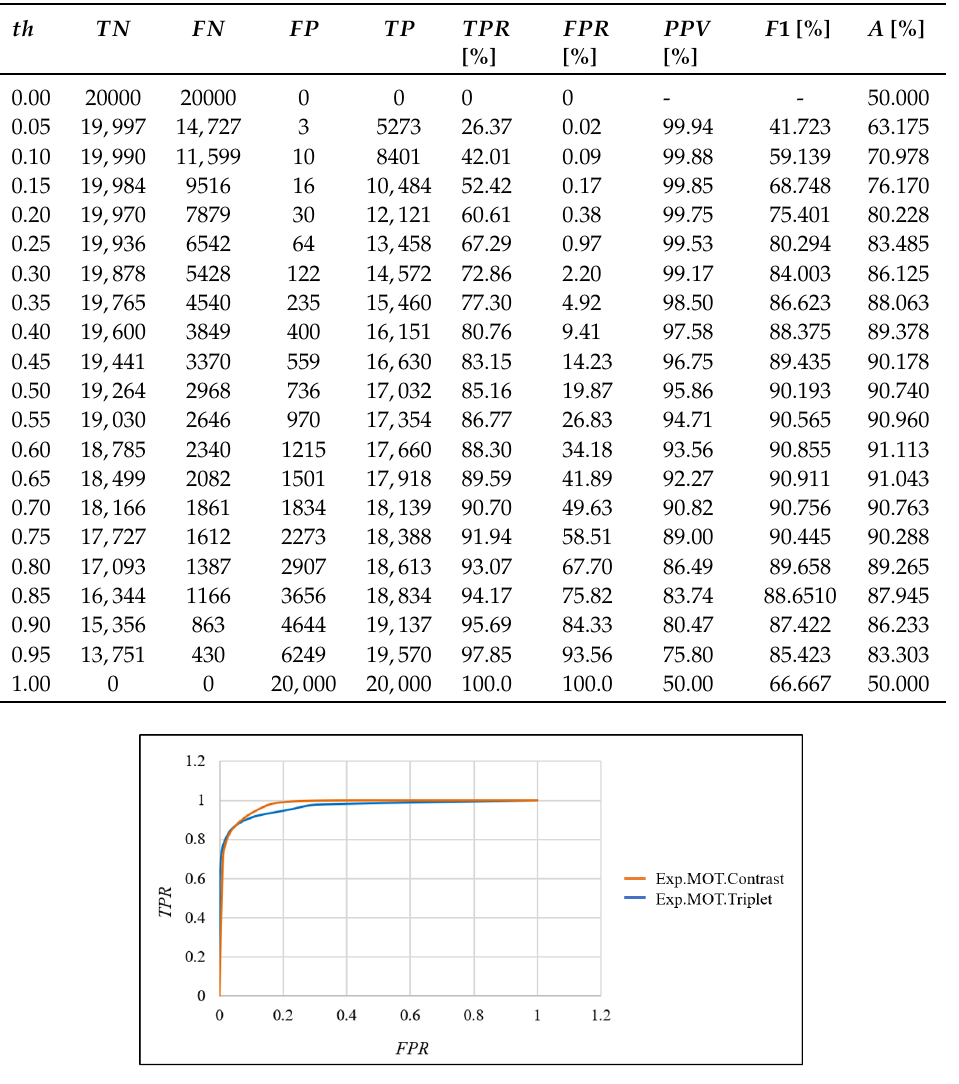
Figure 9. ROC curves for the Appearance Affinity model learnt with the Double-Margin-Contrastive loss and the Triplet loss.